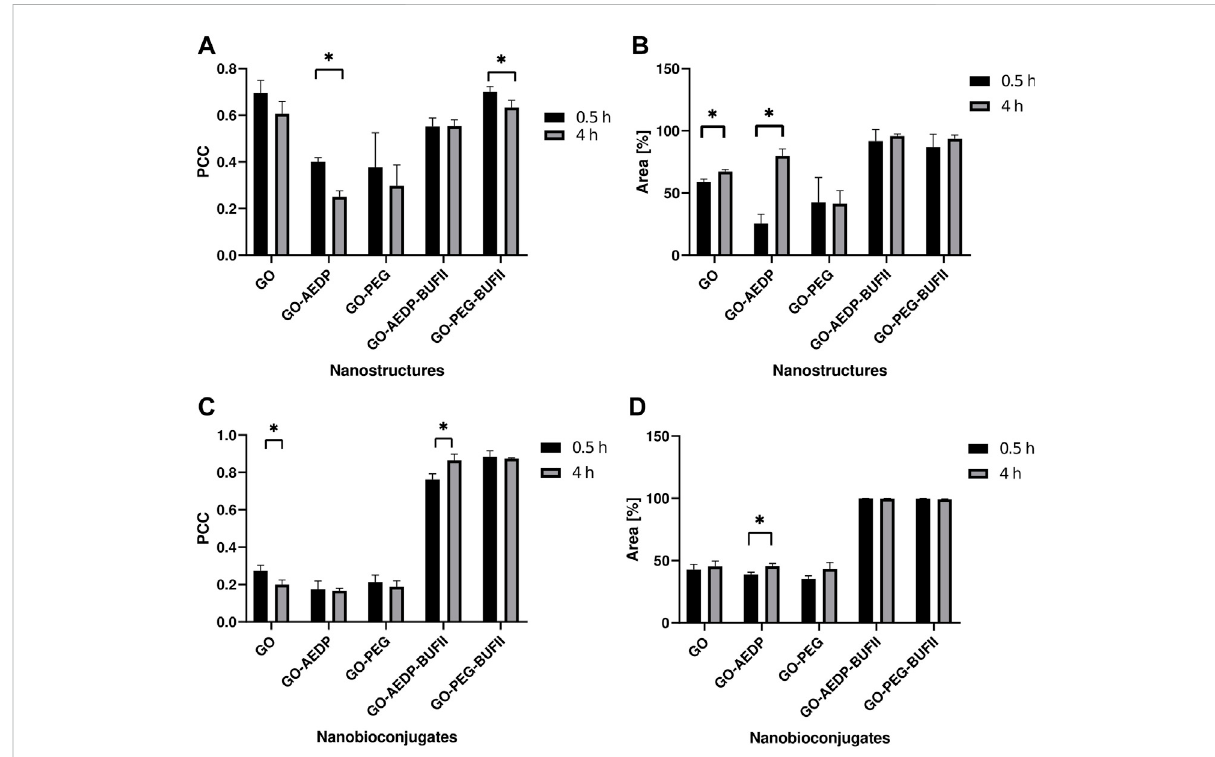
FIGURE 6 Statistical analysis of the confocal images. Endosomal escape and internalization of the nanobioconjugates were quantitatively analyzed by evaluating Vero cells to observe tendencies in: (A) Colocalization with endosomes by calculating the PCC values; (B) Covered area of the nanobioconjugates.Similarly,THP-1cellswereanalyzedtolookfortendenciesin (C) Colocalizationwithendosomes; (D) Coverageareapercentage of the developed nanostructures. Results marked with (*) indicate signi fi cant differences between them ( p -value <